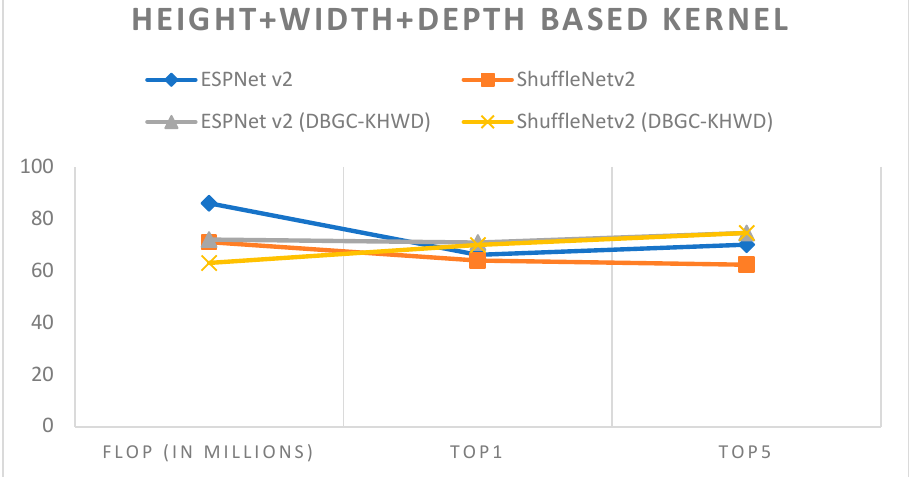
Figure 23. Height+width+depth-based kernel. Figure 23. Height + width + depth-based kernel.